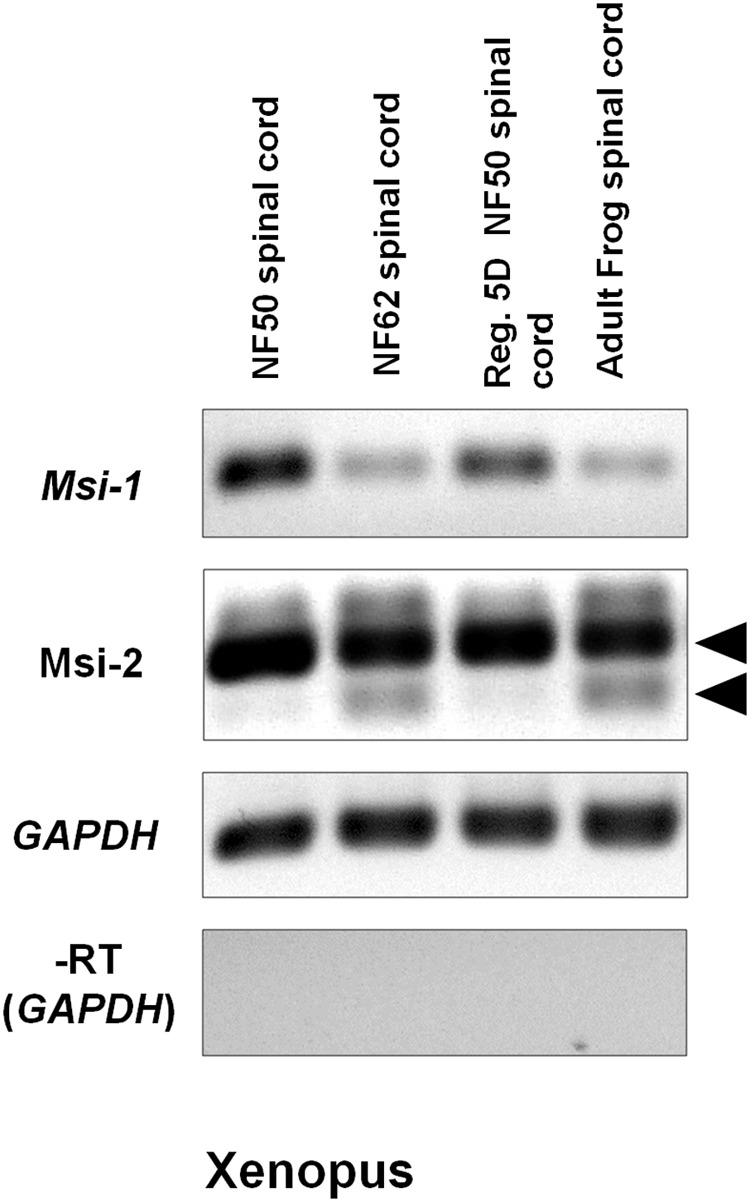
Xenopus Msi-1 and Msi-2 semi-quantitative RT-PCR gels show strong expression of Msi-1 in intact, regeneration-competent NF 50 spinal cord (gel column 1), and 5-day regenerating NF 50 spinal cord (Reg. 5D NF 50 spinal cord, gel column 3). Both Msi-1 and Msi-2 were reduced from NF 50 levels in intact NF 62 (non-regeneration-competent) and adult spinal cord (compare gel columns 1, 2). Msi-2 specific primers showed bands representing the two isoforms shown in the Figure 4 alignments (arrowheads). The larger isoform was universally present. The smaller isoform (lower arrowhead) was present only in NF 62 and adult frog (compare gel columns 2, 4). GAPDH (glyceraldehyde-3-phosphate dehydrogenase) was used as the housekeeping control gene. The No-RT control (–RT) was performed without reverse transcriptase using the GAPDH primers. Each gene is shown in a separate row. All bands in each row are from one original gel. Negative was shown as for image clarity.